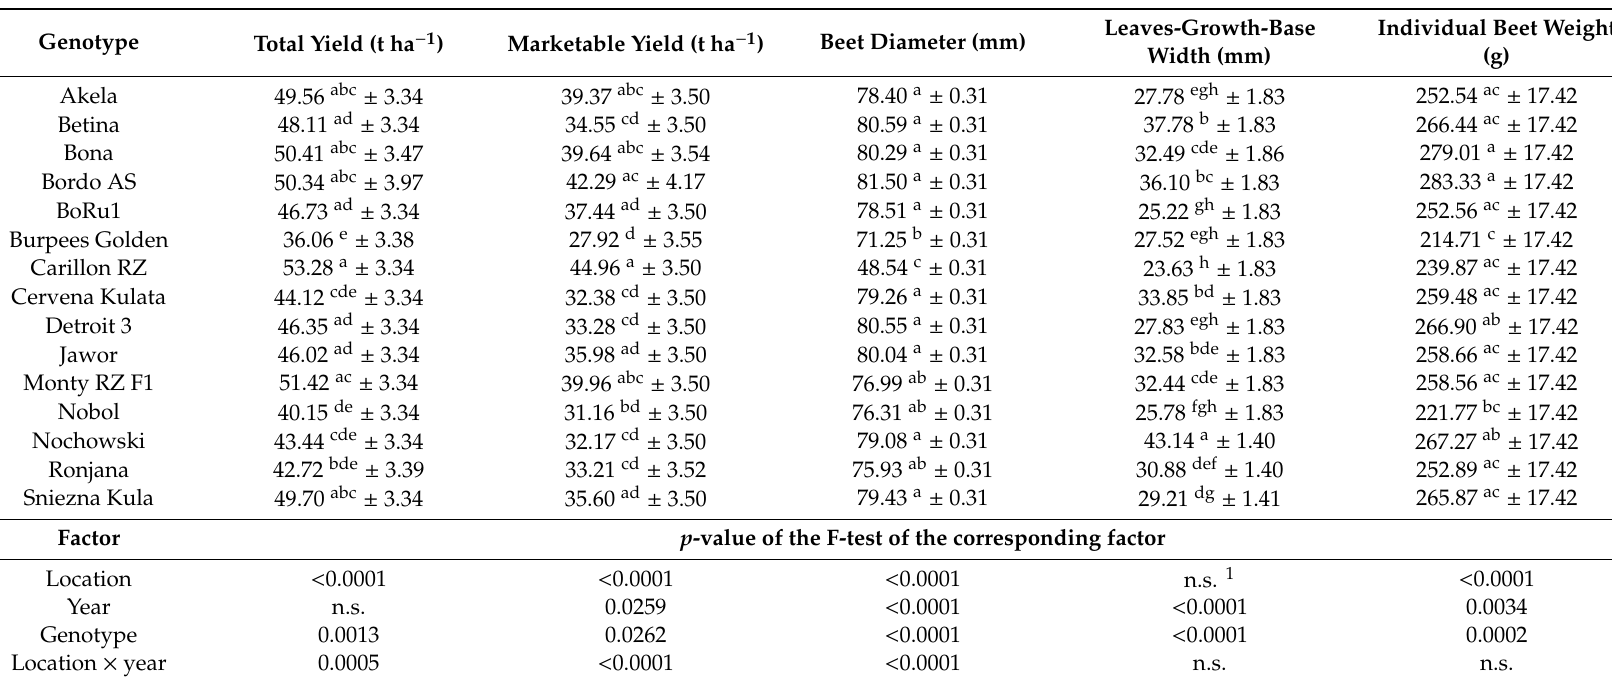
Table 3. Mean values and analysis of variance (ANOVA) of results of total yield (t ha − 1 ), marketable yield (t ha − 1 ), beet diameter (mm), leaves-growth-base width (mm), and individual beet weight (g) of 15 di ff erent genotypes of beetroot grown in three research stations within the trial year 2017 and 2018. Results represent the mean values ± standard error. Means followed by at least one identical letter were not significantly di ff erent from each